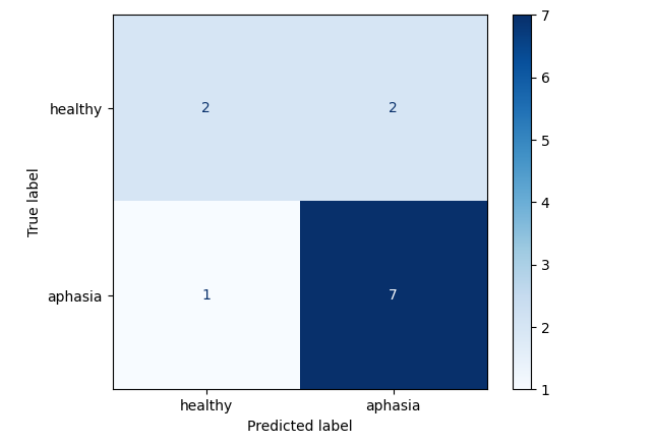
Figure 5. Confusion matrix from kNN binary classification (PPA vs. CG) model for the test